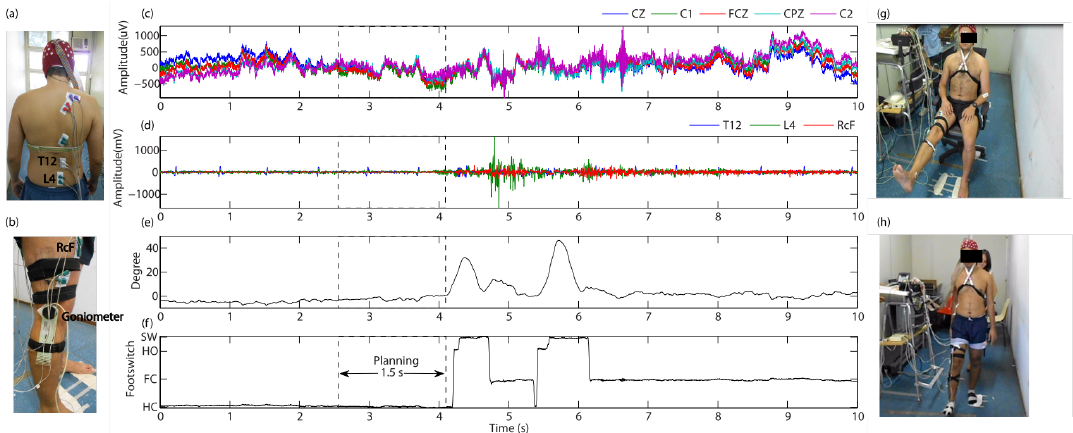
Figure 3. Representation of the experimental setup, used at the protocol. Some EEG and sEMG channels acquired during two steps are displayed. ( a ) sEMG electrodes placed on the erector spinae muscle at five levels; ( b ) sEMG electrodes and goniometer sensor placed on the right leg; ( c ) EEG signals; ( d ) sEMG signals; ( e ) knee angle; ( f ) signal related to the foot contacts on the floor during two steps; ( g ) knee extension; ( h )